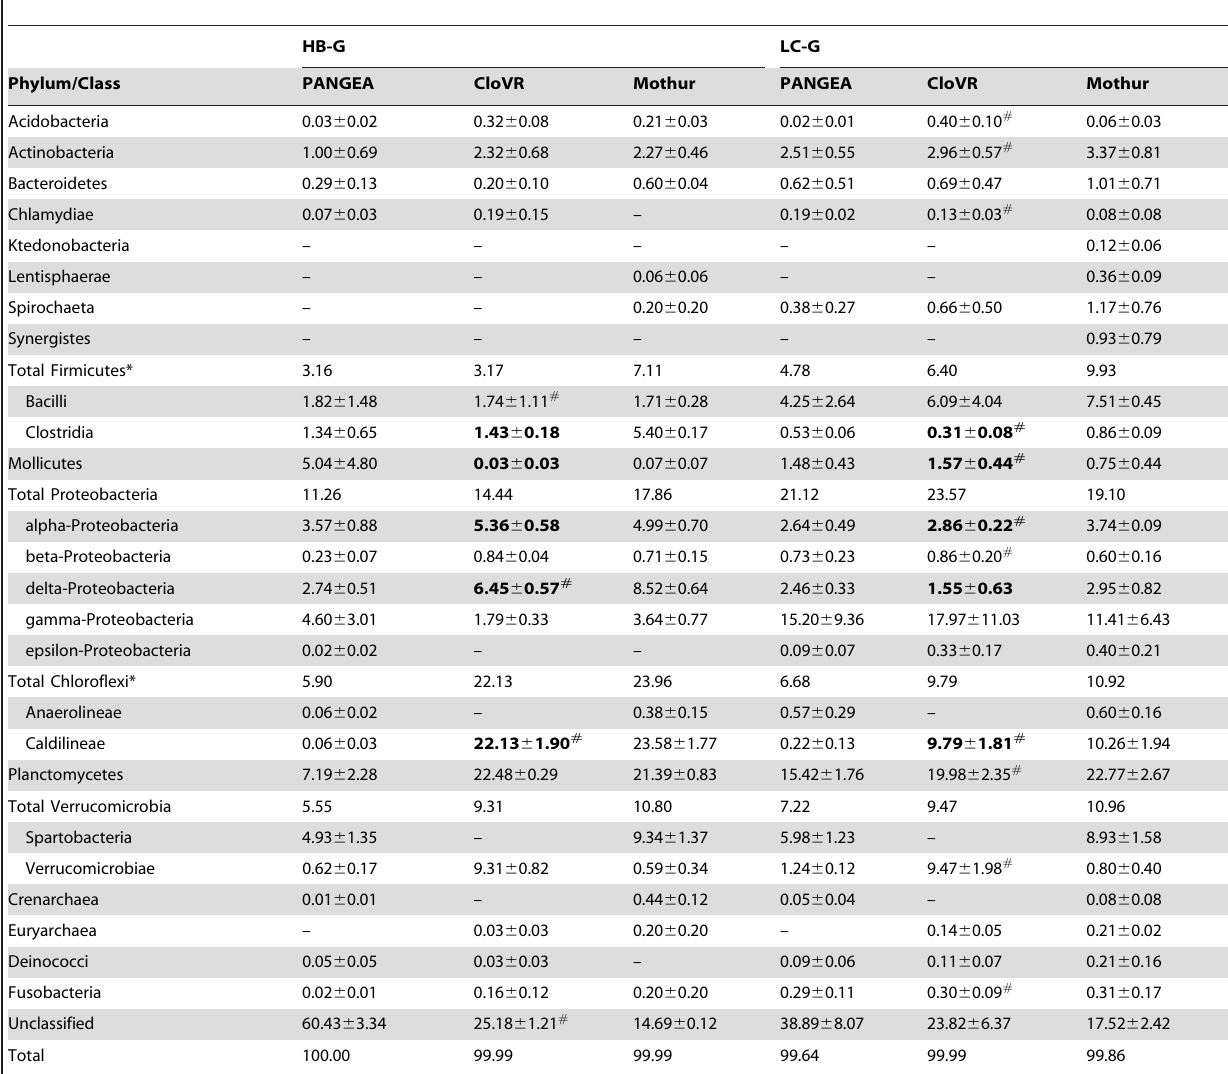
Table 2. Hackberry Bay and Lake Caillou oyster gut microbiome compositions and values as in Table 1.